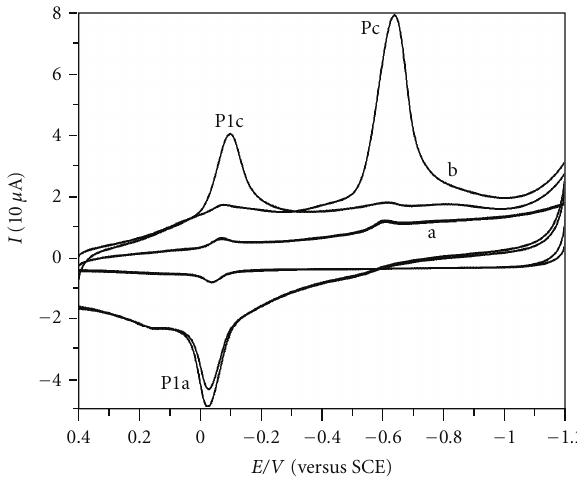
Figure 4: Cyclic voltammograms of 1.9 × 10 − 5 molL − 1 parathion at a bare GCE (a) and a poly(safranine) film-modified electrode (b) in pH 6.0 PB solution. Scan rate: 100mVs − 1 .